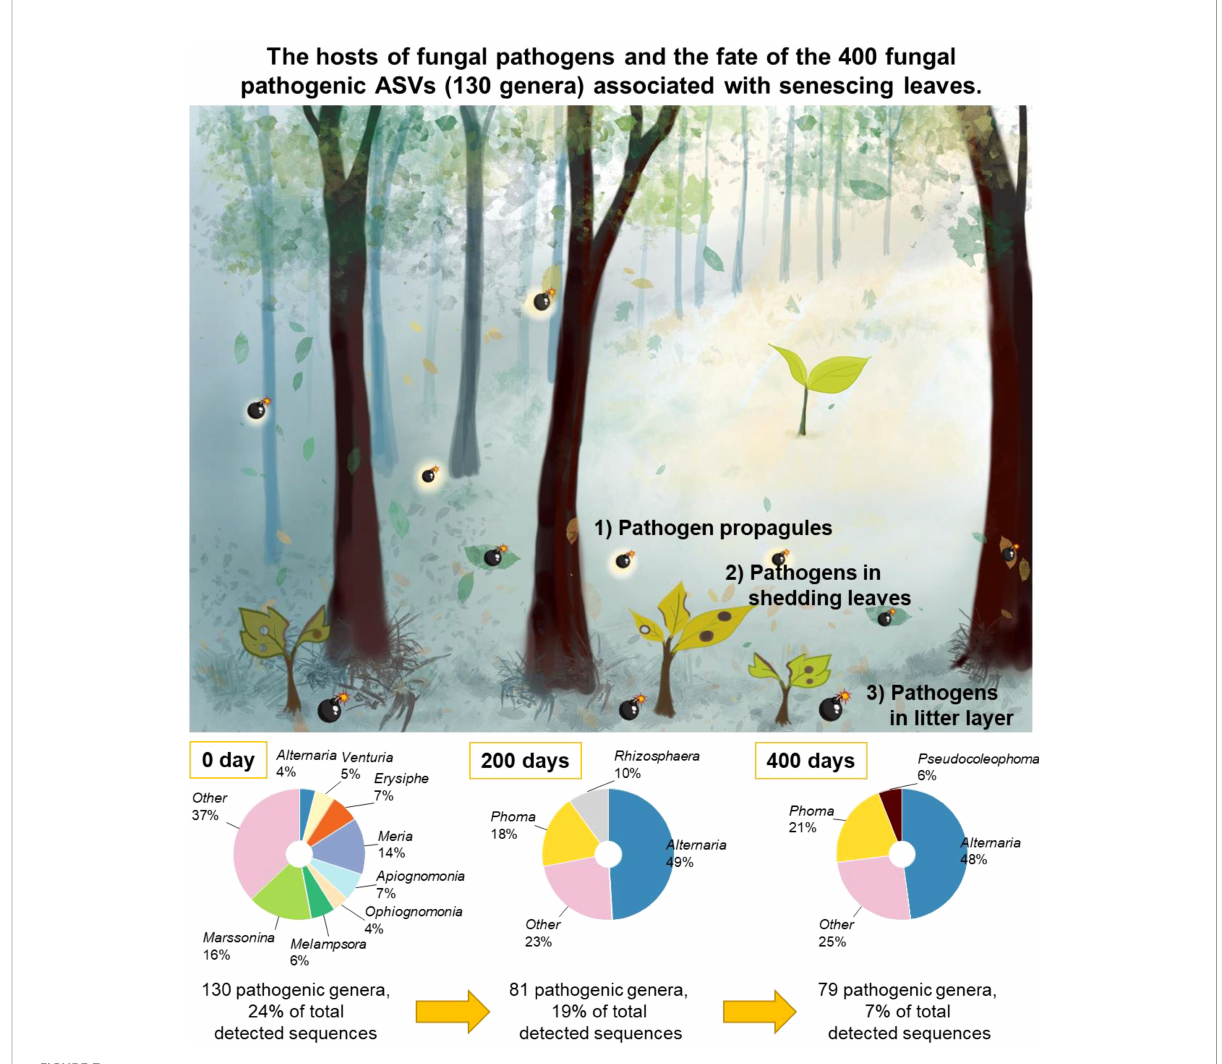
FIGURE 7 The fate of the 400 fungal pathogenic ASVs associated with senescing leaves and needles. Leaf-associated fungal pathogens at 200 and 400 days were characterized by fungal internal transcribed spacer (ITS)-based amplicon sequencing on the Illumina MiSeq sequencing with the same